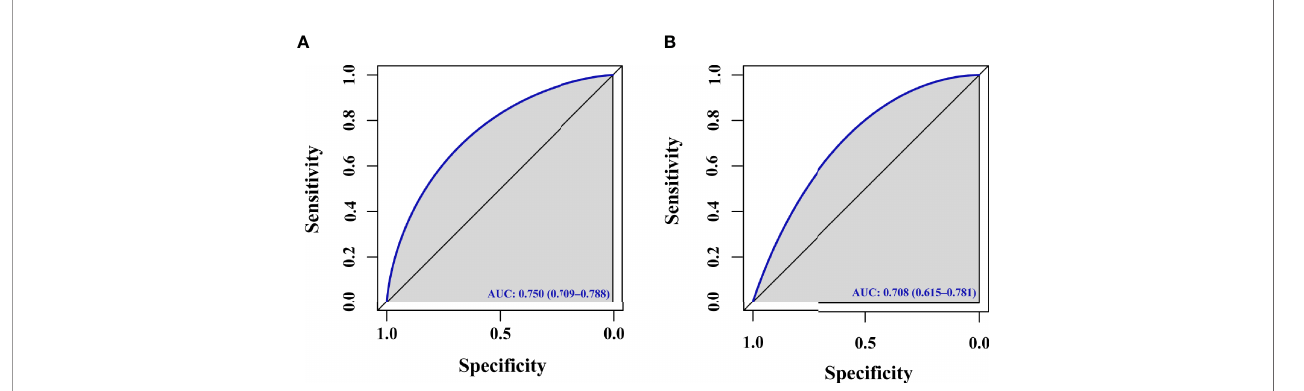
FIGURE 4 | ROC curve. (A) ROC curve evaluating the ability of this model to predict live births for PCOS patients in the training cohort undergoing F-ET. (B) ROC curve evaluating the ability of this model to predict live births for PCOS patients in the validation cohort